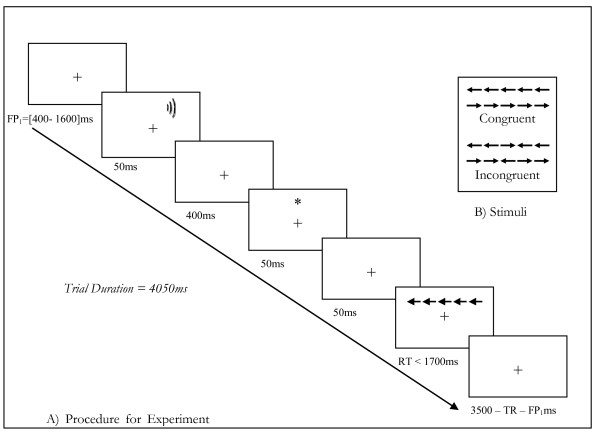
Sequence of events appearing on each trial in the modified version of ANT experiment. Part A shows the actual sequence of events during the ANT task in our study. Part B shows examples of the target display in the congruent and incongruent condition. Stimuli: The stimulus used for the orienting signal was an asterisk presented at the same location as the target (2.9° of visual angle above or below the fixation point). For the alerting signal, a 2000 Hz and 50 ms sound was used. Lastly, the target display was made up by a target arrow that could point either to the left or to the right and four flankers that could be just plain black lines or arrows pointing either left or right. The length of the arrows was 0.55° and they were 0.06° away from each other. Description of the task: In half of the trials, 50 ms before the target an auditory alerting signal was presented (fig1). After a 400 inter-stimulus-interval (ISI), an orienting cue was presented on 2/3 of the trials above or below the fixation point for 50 ms. After another 50 ms ISI the target and flankers were presented either at the same or the opposite location than the previous orienting signal for 1700 ms, or until the participant gave a response. Then the fixation point that had been presented during the whole trial was kept for a variable duration dependent on the duration of the initial fixation point and on the reaction time of the subject so that every trial was same duration (4050 ms). No screen was presented between trials. Consequently, participants did not know when a trial had finished and the next one was to begin providing uncertainty about the appearance of the signals and increasing their informative value.